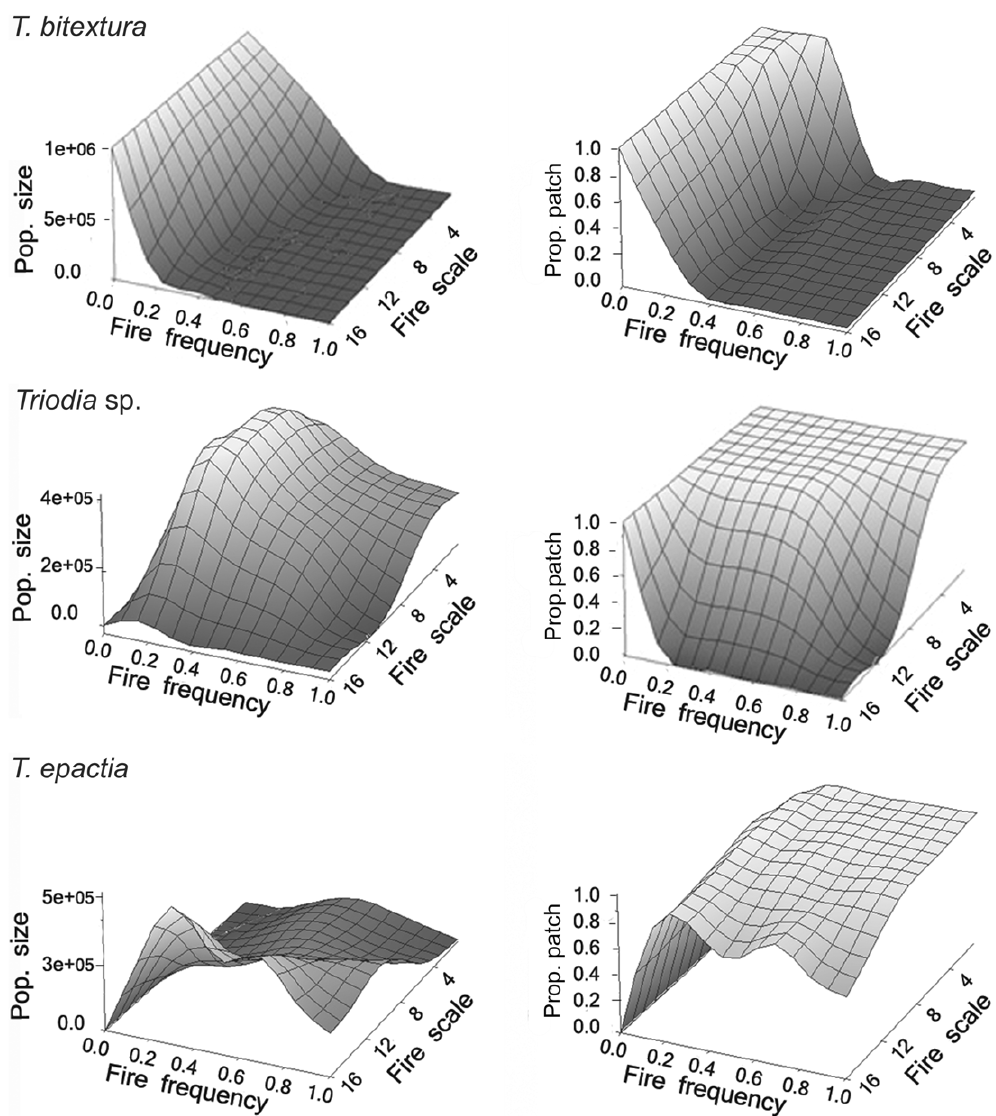
Figure 3. The mean population size and proportion of patches occupied for each species at different fire frequencies and scales over the entire ‘landscape’ with all species in competition.